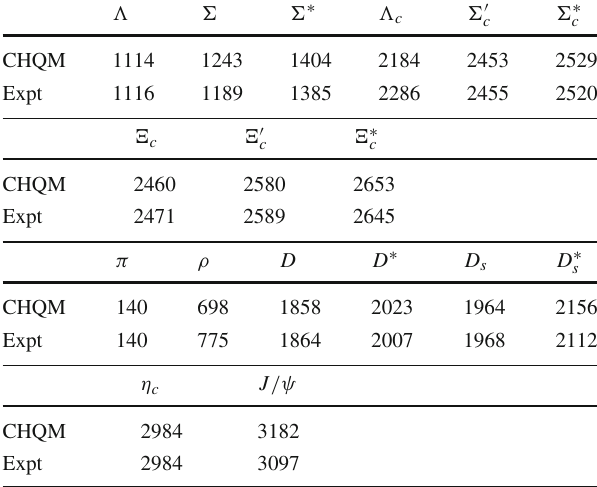
where n max is the number of Gaussian functions, and n max is determined by the convergence of the results. In the present calculation, n max = 8. The details of constructing flavor, color and spin wave functions of 5-quark system can be found in Ref. [38], only the last expressions are shown here. Flavor wave functions: